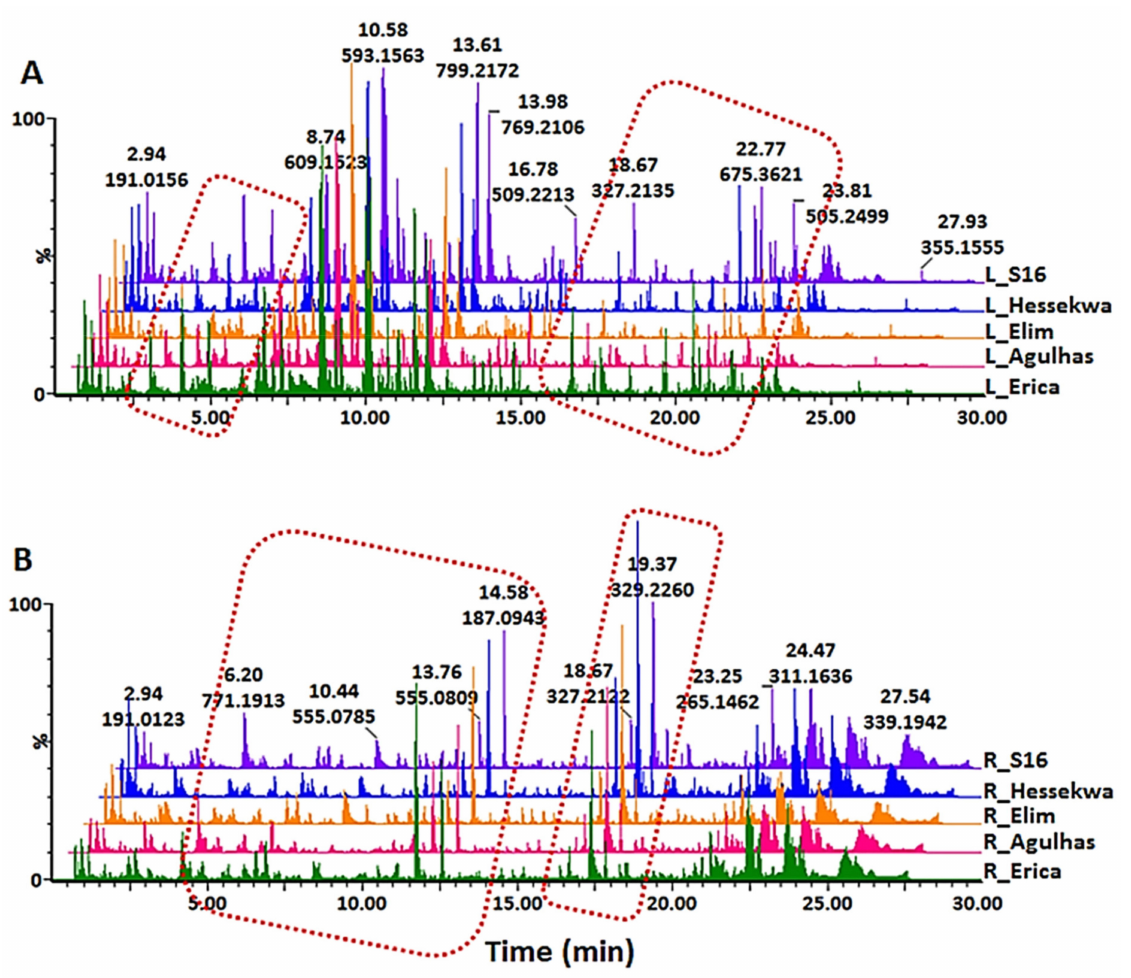
Figure 1. Ultra-high performance liquid chromatography–mass spectrometry (UHPLC-MS) base peak intensity (BPI) chromatograms in negative electrospray ionisation (ESI) mode of ( A ) leaf and ( B ) root extracts from five different barley cultivars (‘Erica’, ‘Elim’, ‘Hessekwa’, ‘S16’ and ‘Agulhas’) under controlled conditions and harvested after 21